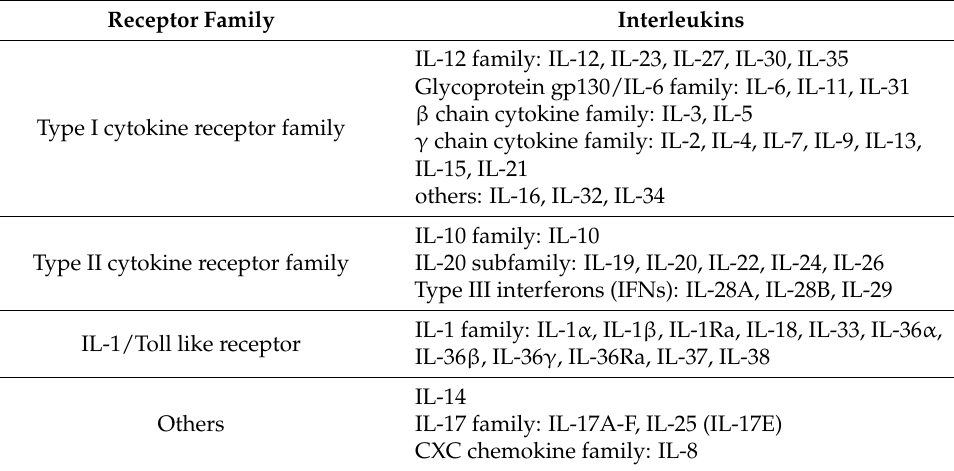
Table 1. Known interleukins grouped according to their respective receptor families. References for Table 1